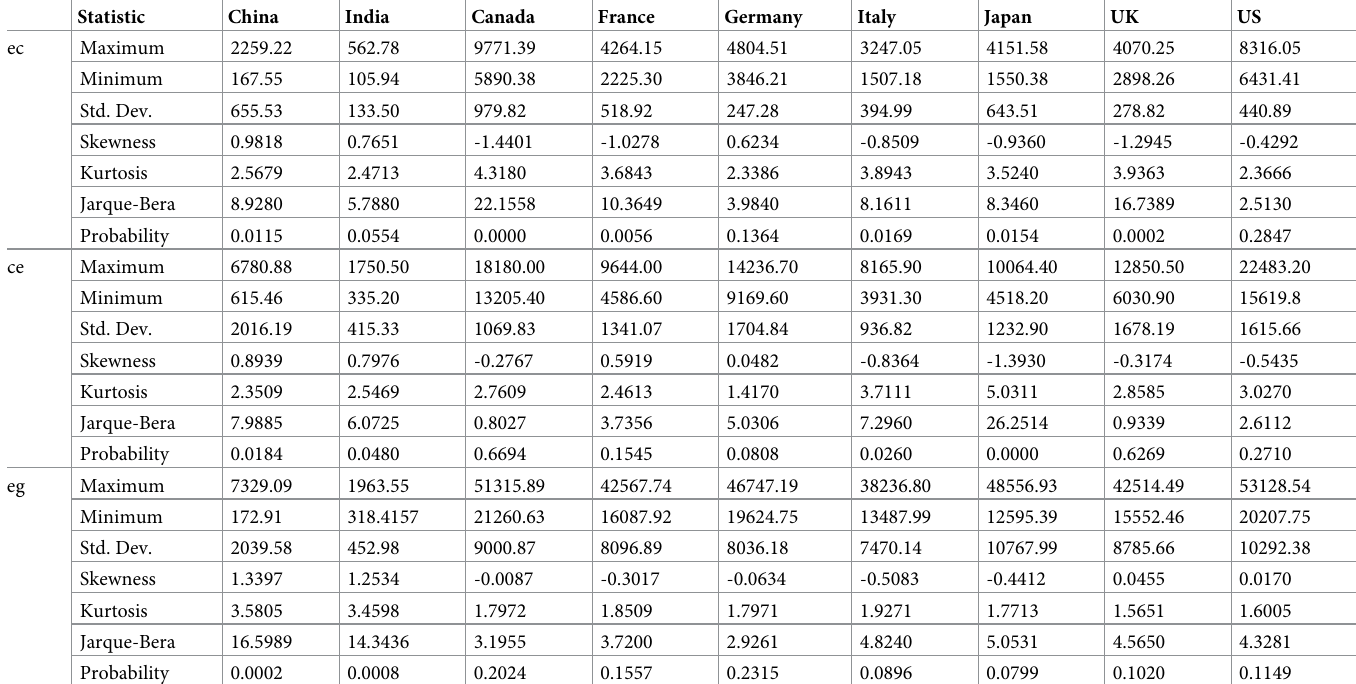
Table 2. Descriptive statistics for the per capita